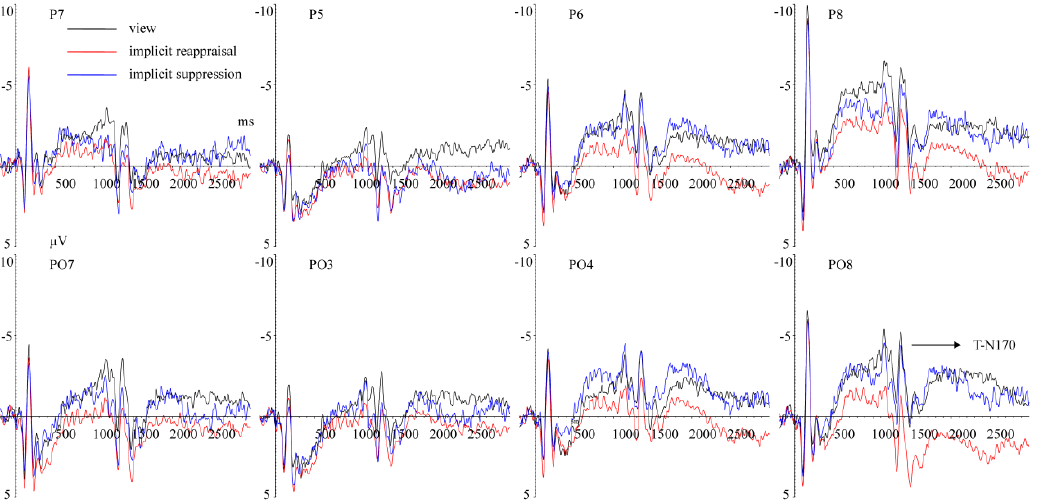
Figure 5. Grand average ERPs of T-N170 components for view (black lines), implicit reappraisal (red lines), and implicit suppression (blue lines), under implicit fear priming condition, recorded at P5, P6, P7, P8, PO3, PO4, PO7, and PO8.